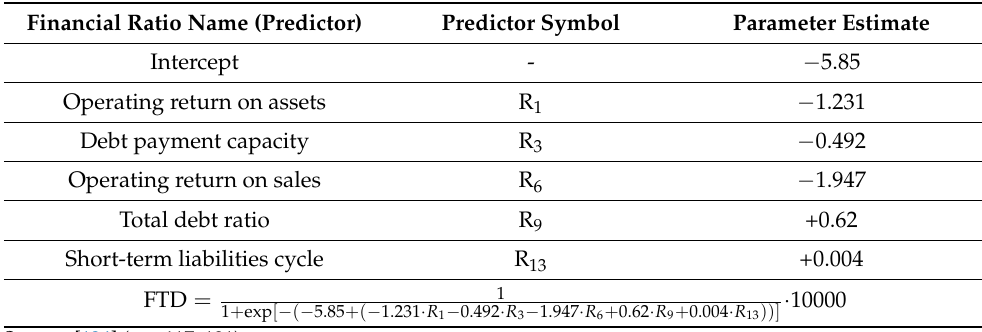
Table 1. Estimated prediction logit model of the financial threat